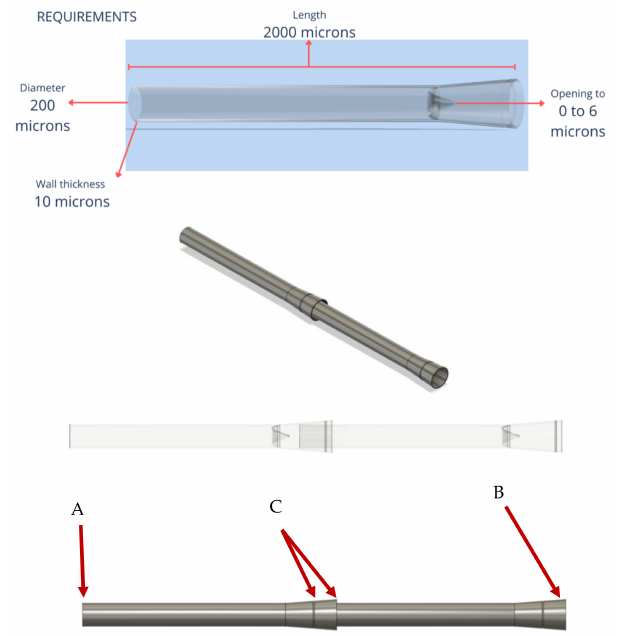
Figure 6. Wireframe model modular lymphatic vessels